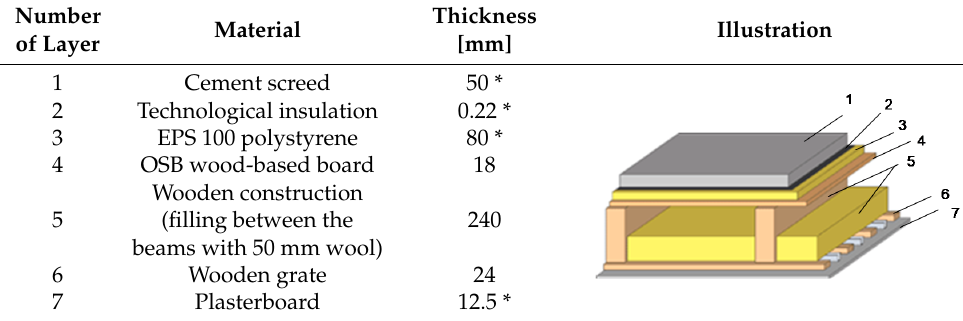
Table 2. Inter storey ceiling in Wolf system.